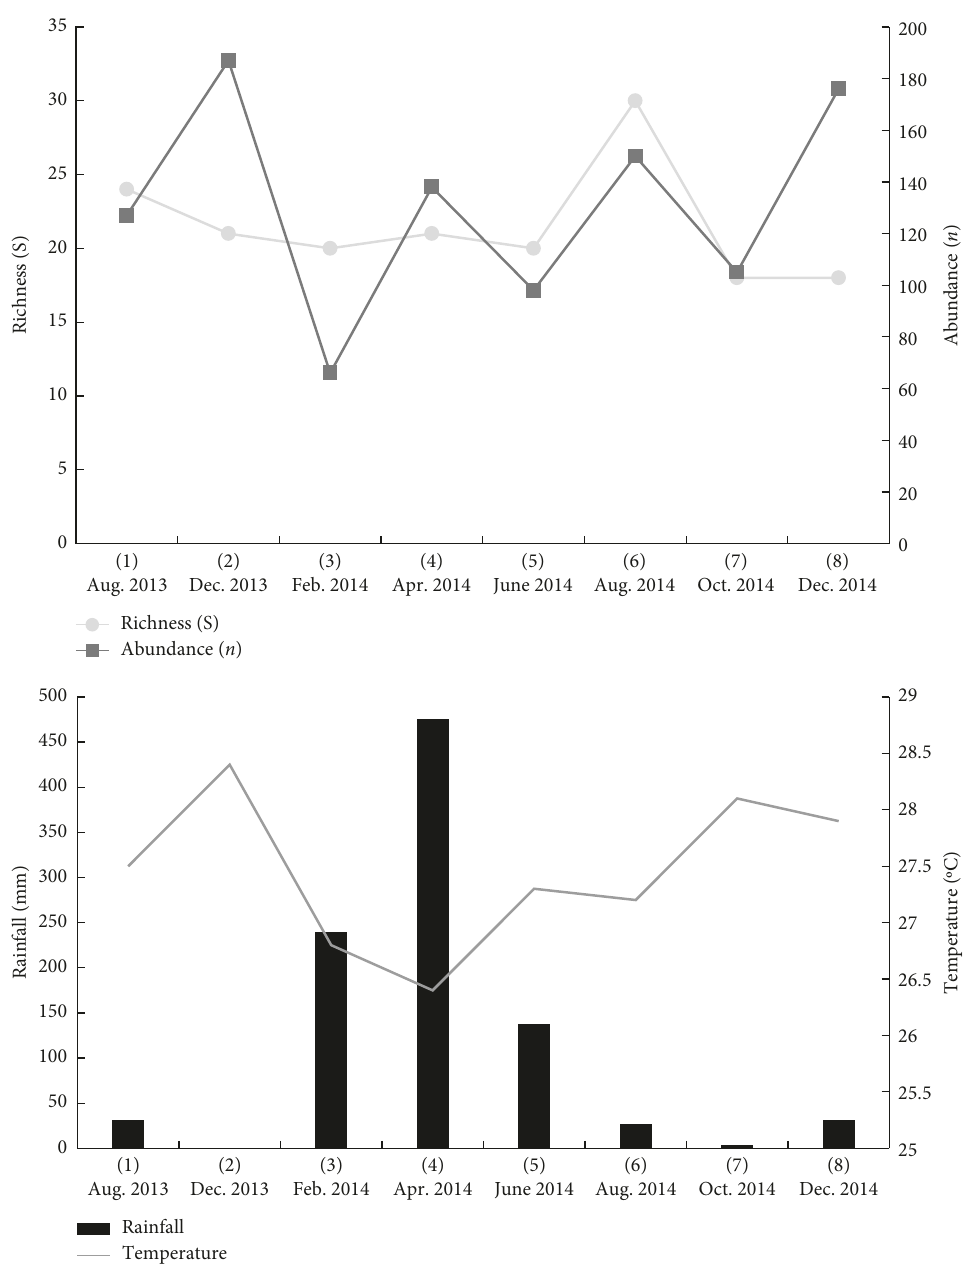
Figure 2: Distribution of bee sample richness and abundance and climate data between August 2013 and December 2014 in Carutapera, MA,